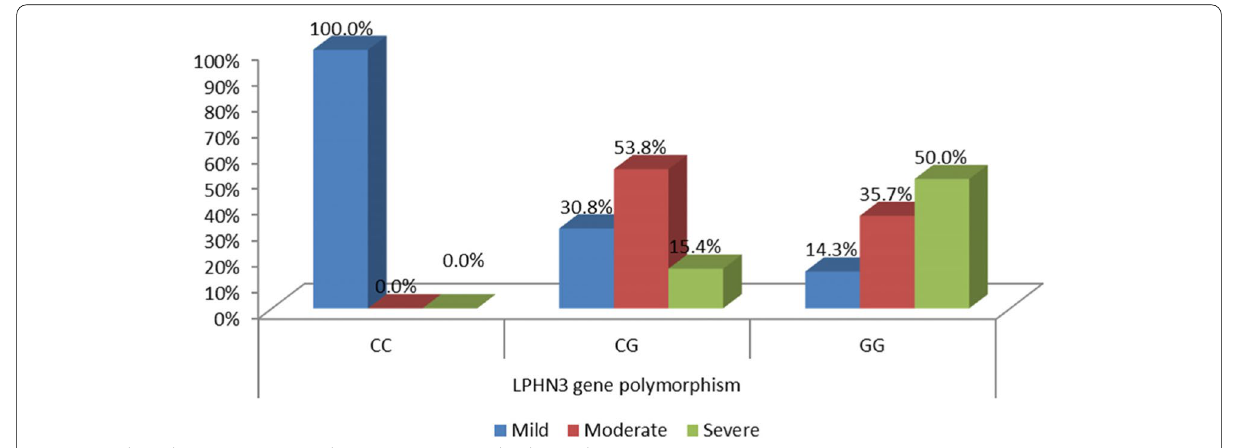
Fig. 1 Bar chart showing association between severity and